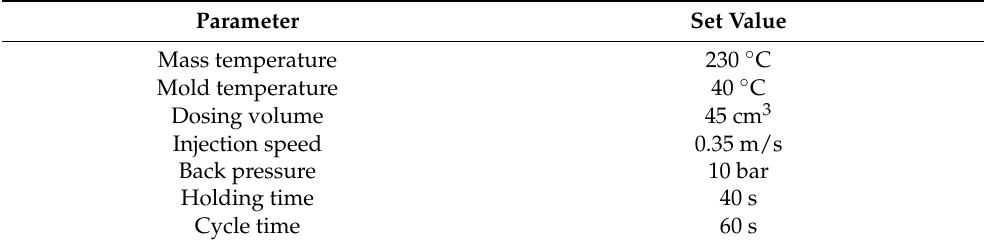
Table 3. Injection-molding parameters applied for all mixtures. Parameters were chosen following ISO 3167 and adjusted to obtain the proper mold filling. Additionally, a low back pressure was chosen to inflict less shear, and therefore less fiber damage, to the